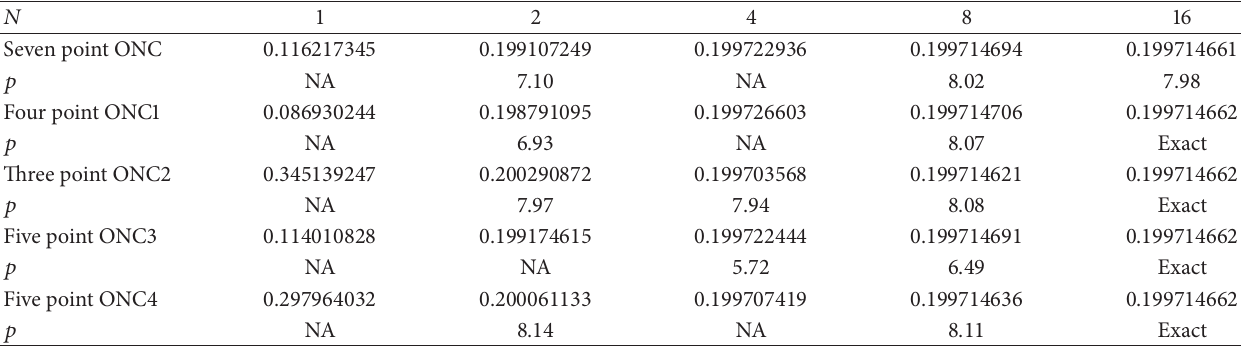
3 𝑒 −2𝑥 sin (4𝑥)𝑑𝑥 . 0